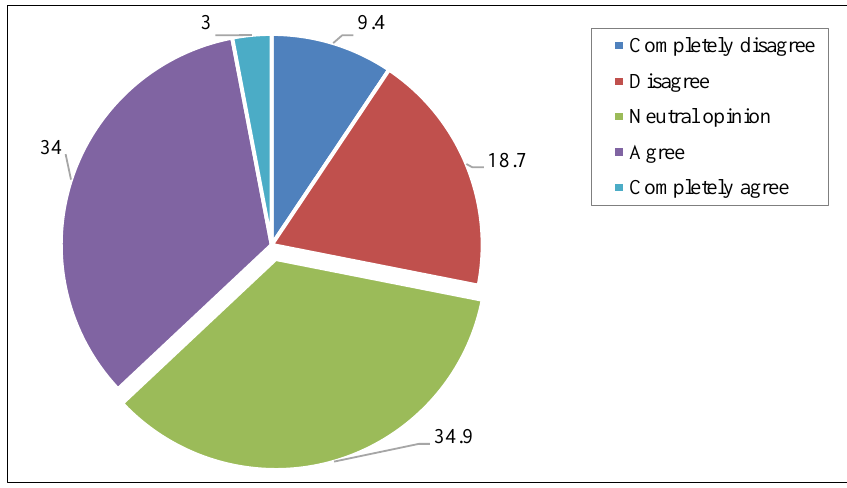
Figure 5. Enterprises enhancing the capacity to meet the market